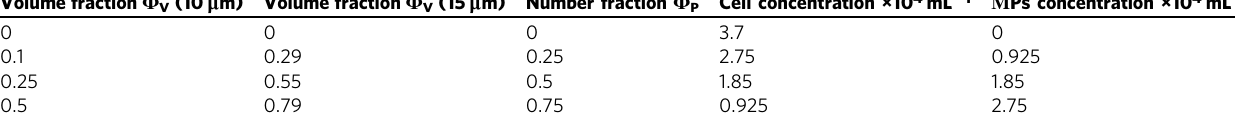
Table 2 Fraction of polystyrene beads in the hanging